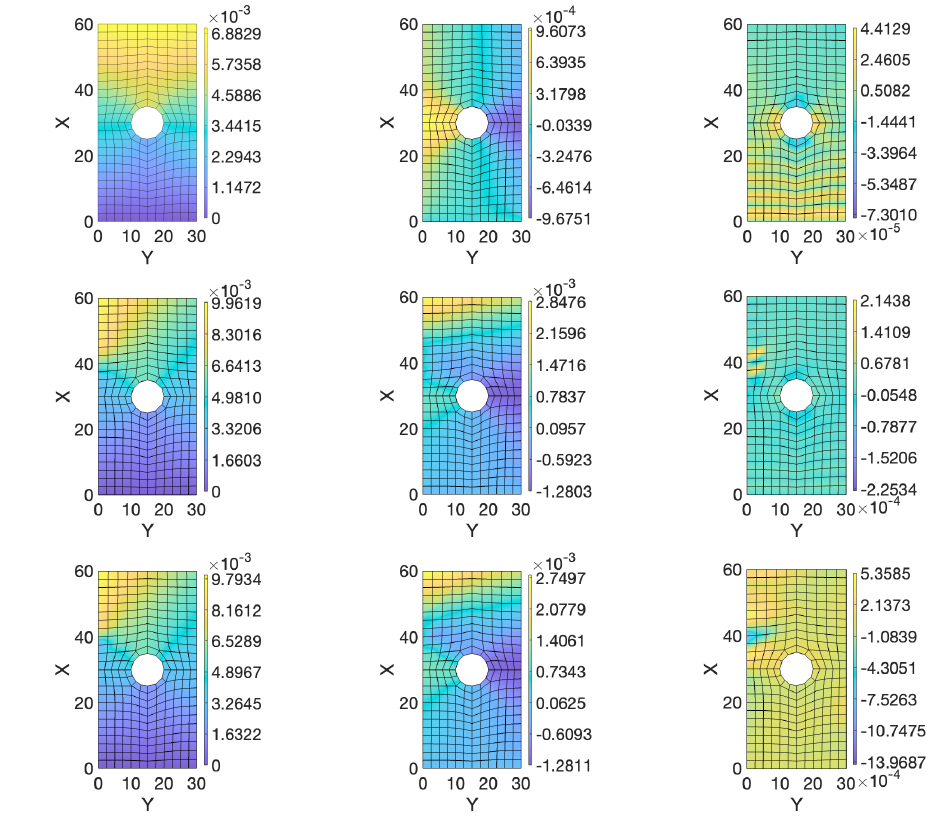
Figure 11. Top view of x ( left ), y ( center ) and z ( right ) components of the displacement field associated with the nominal solution ( top ); reference solution that takes into account the real damaged region ( middle ) and corrected model solution ( bottom ).